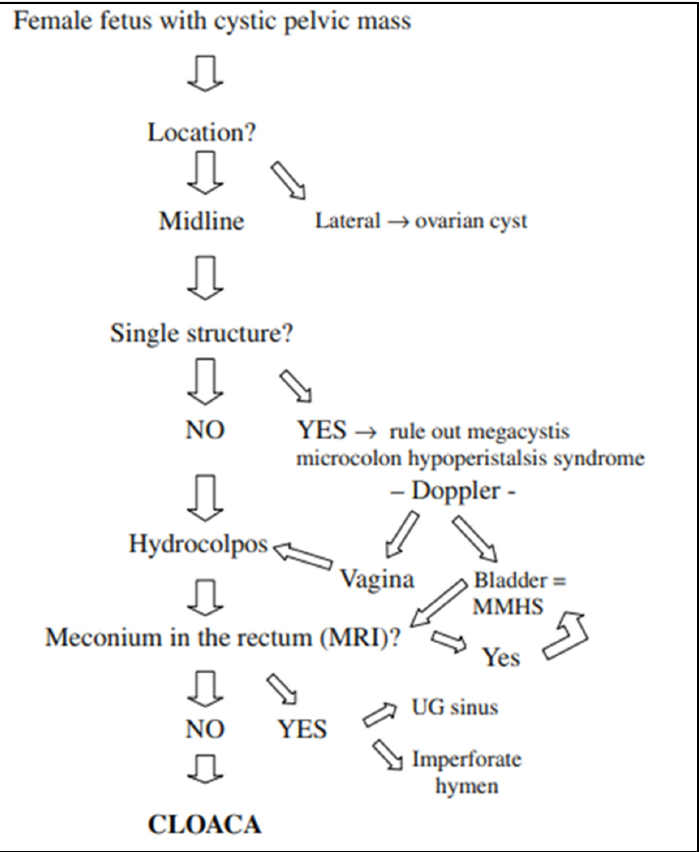
Figure 2. Algorithm for abdominal cystic mass in female fetuses. Adapted from Bischoff, et al. (2010) [11].